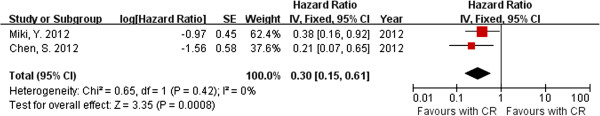
Hazard ratio for overall survival of patients with liver metastasis received combined hepatic resection or not. (C: chemotherapy; CR: combined resection).